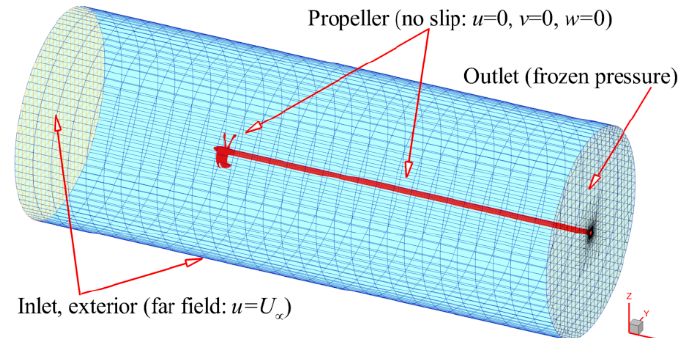
Figure 3. Computational domain and boundary conditions formulation.